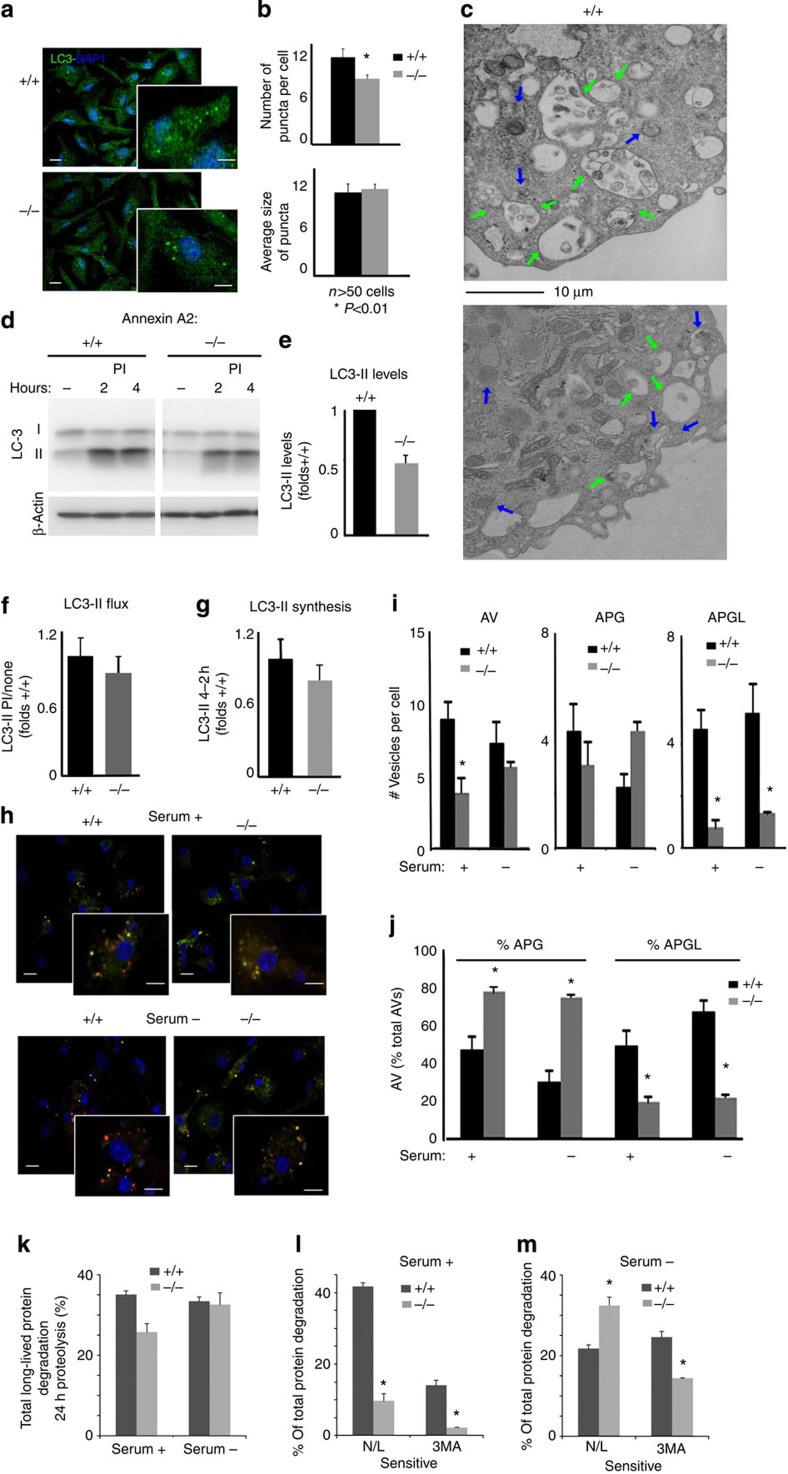
Reduced autophagosome biogenesis and autophagic flux in DC from Anxa2−/− mice.(a) Immunofluorescence for LC3 in dendritic cells of Anxa2+/+ and Anxa2−/− mice. Nuclei are highlighted with DAPI. Insert shows higher magnification. Scale bars: 10 and 5 μm (insert). (b) Quantification of the number of puncta per cell, and average size of LC3-positive puncta, in micrographs such as shown in a; the mean and s.e. were calculated from n>75 cells; *P<0.05. (c) Electron microscopy of the same cells. Arrows mark autophagosomes (blue) and autolysosomes (green). Scale bar: 10 μm. (d) Immunoblot for LC3 in Anxa2+/+ and Anxa2−/− dendritic cells untreated (none) or incubated with lysosomal protease inhibitors (PI) for the indicated times. Actin is shown as loading control. (e–g) Quantification of steady-state levels of LC3-II (e), increase in LC3-II levels upon lysosomal proteolysis blockage (f) and increase in LC3-II at the two times of PI treatment (g) calculated from immunoblots shown in d. n=3. (h) Direct fluorescence microscopy in Anxa2+/+ and Anxa2−/− dendritic cells transiently transfected with the tandem reporter mCherry-GFP-LC3, and maintained in serum-supplemented or serum-depleted medium for 6 h. Inserts show higher magnification images. Scale bars: 10 and 5 μm (insert). (i) Quantification of the number of total autophagic vacuoles (AV; mCherry+). Autophagosome (APG, mCherry+ and GFP+) and autolysosomes (APGL, mCherry+ and GFP−) in images such as in h; the mean and s.e. were calculated from n>75 cells; *P<0.05. (j) Quantification of the percentage of autophagosomes and autolysosomes; *P<0.05. (k–m) Rates of degradation of long-lived proteins in Anxa2+/+ and Anxa2−/− dendritic cells maintained in the presence or absence of serum for 24 h. Total rates of protein degradation (k), and degradation sensitive to lysosomal inhibition (combination of ammonium chloride and leupeptin (N/L)) or to inhibition of macroautophagy (3-methyl adenine (3MA)), in cells maintained in the presence (l) or absence (m) of serum. n=6; *P<0.05 (all unpaired two-tailed Student’s t-test).